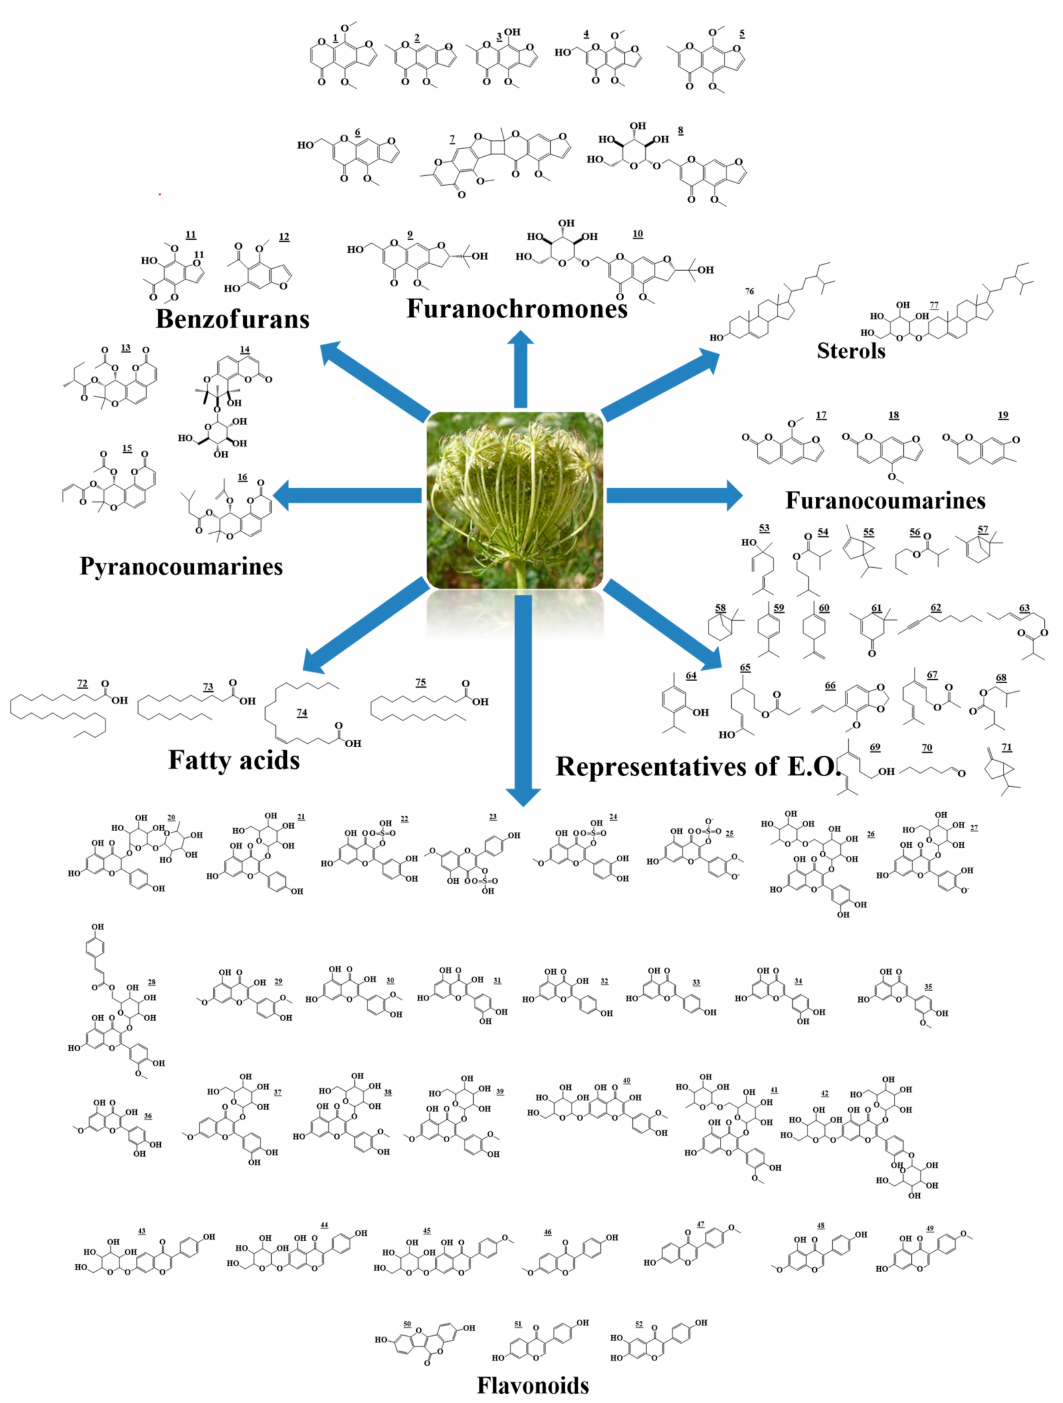
Figure 1. Metabolites previously isolated from A . visnaga